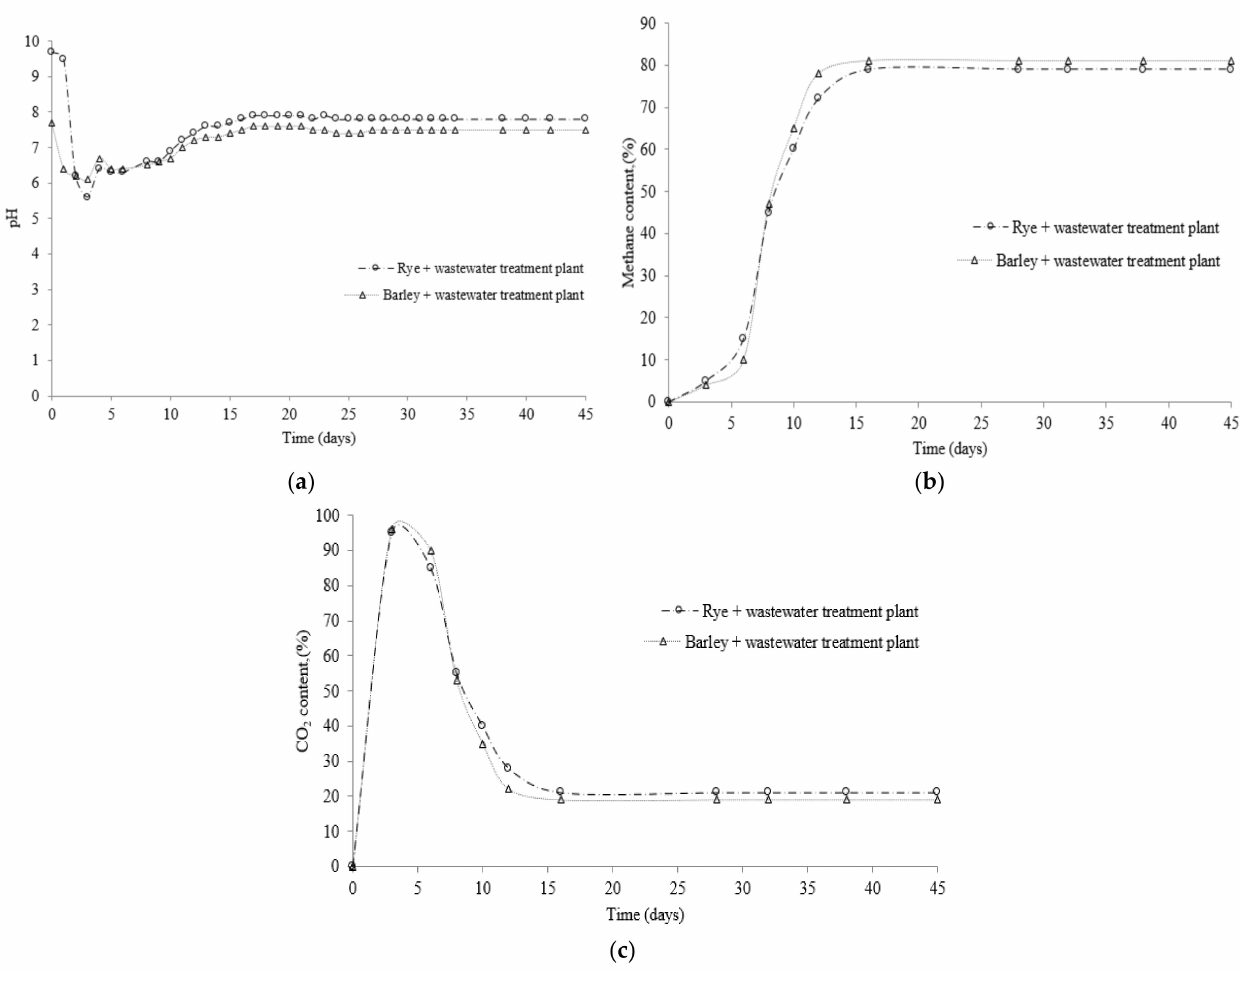
Figure 5. Substrate evolution during biogas production tests in large-scale reactors: ( a ) pH evolution; ( b ) Methane production; and ( c ) Carbon dioxide production. Table 3. Biogas production in the large-scale